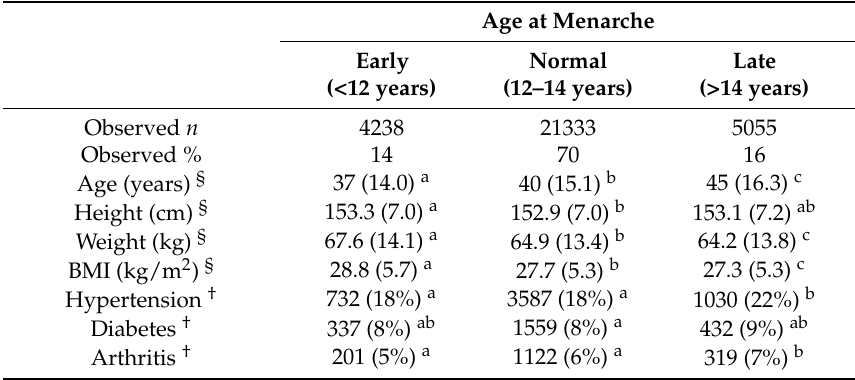
Table 1. Descriptive characteristics of study population per age at menarche